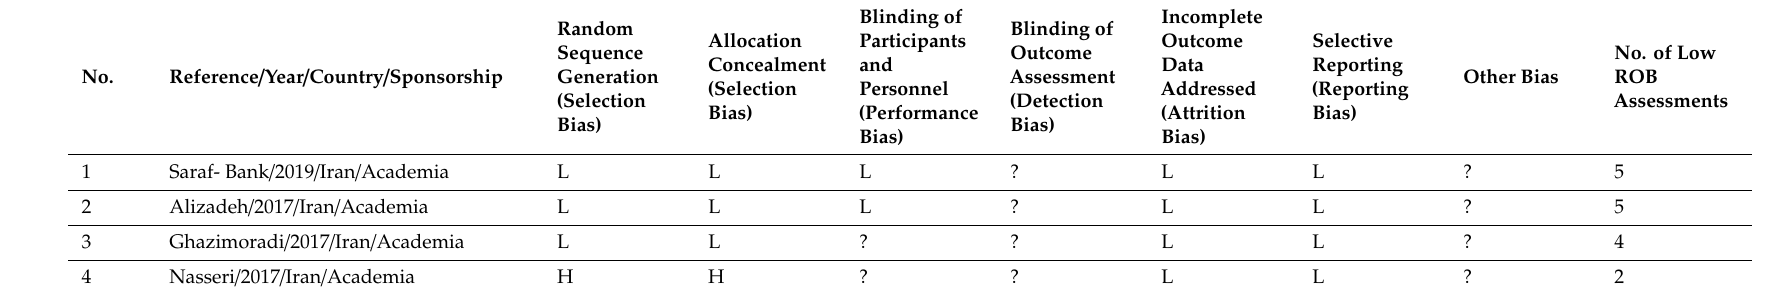
Table 2. Risk of bias